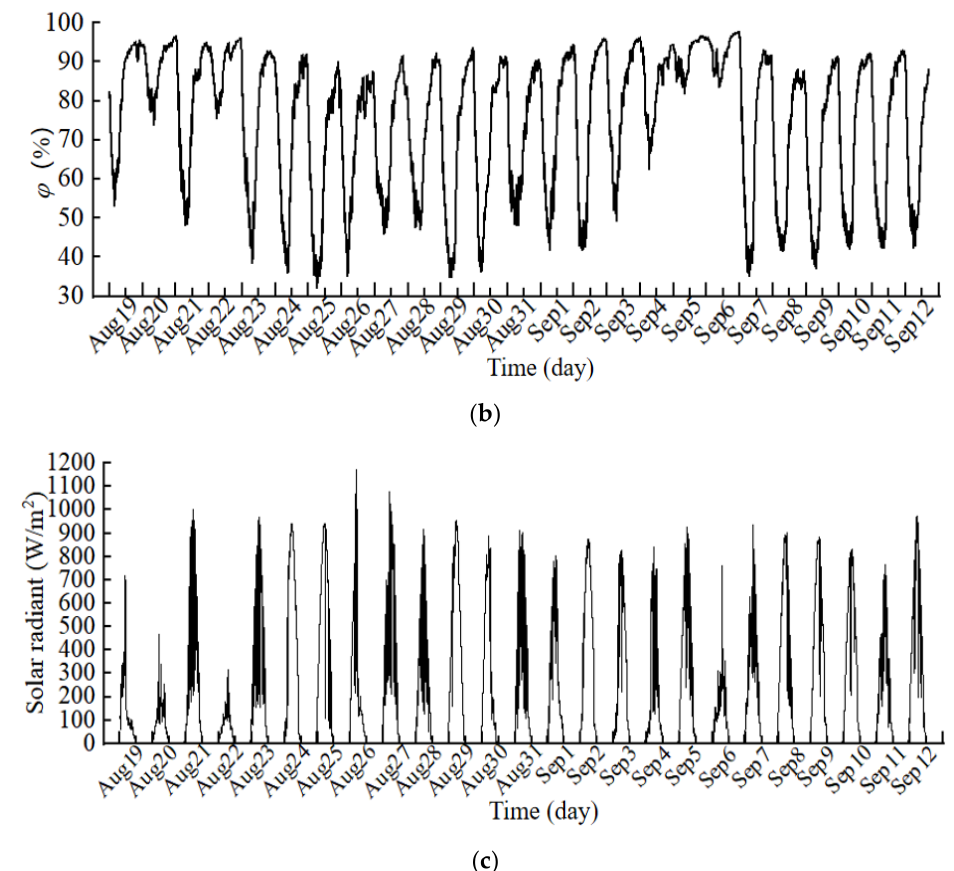
Figure 7. Meteorological conditions during the experiment, ( a ) outdoor air temperature, ( b ) outdoor air relative humidity, and ( c ) solar radiation.